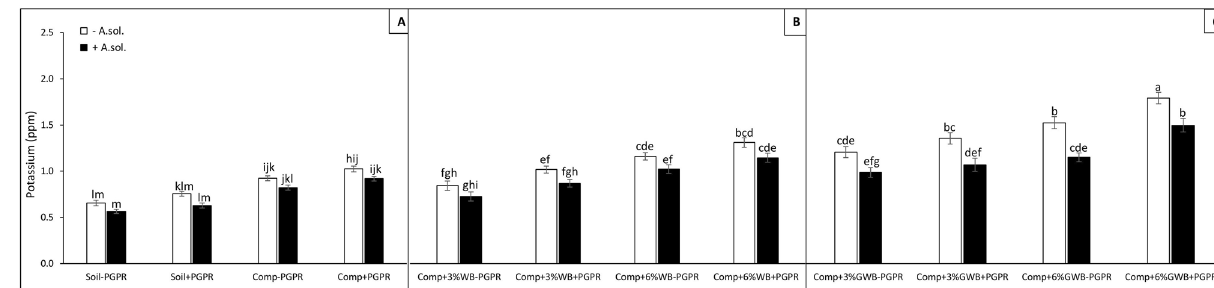
Figure 6. Effect of Alternaria solani and PGPR on potassium contents of leaf tissues in leaf tissues of tomato raised in various soil substrate compositions including; ( A ) soil and compost (Comp) alone with (+ PGPR) and without PGPR (− PGPR), inoculated (+ A. solani ) or un-inoculated (− A. solani ), ( B ) compost (Comp) with 3 and 6% wood biochar (WB) with (+ PGPR) and without PGPR (− PGPR), inoculated (+ A. solani ) or un-inoculated (− A. solani ), ( C ) compost (Comp) with 3 and 6% Green waste biochar (GWB) with (+ PGPR) and without PGPR (− PGPR), inoculated (+ A. solani ) or un-inoculated (− A. solani ). All values represent mean ± SE, recorded 40 days after transplantation. Bars with different letters on the top suggest significant difference as per Tukey’s HSD test ( P ≤